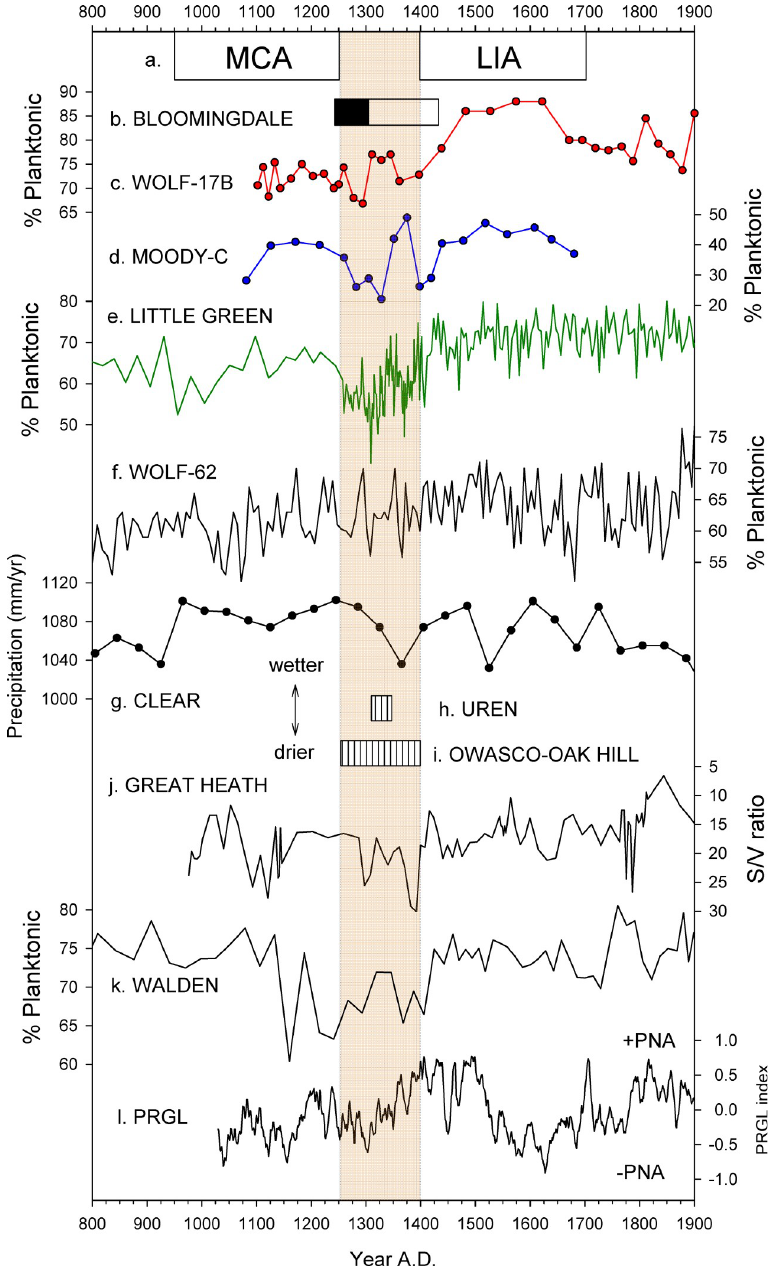
Fig 5. Paleoclimatic and cultural records of the last millennium. (a) MCA = Medieval Climate Anomaly, LIA = Little Ice Age. Tan column spans the MCA-LIA transition A.D. 1250–1400. (b) Age probability ranges for the resumption of peat deposition in Bloomingdale Bog after hiatus. Black box = this study, open box = [6]. (c-e) %P in cores from Wolf Lake, Moody Pond, and Little Green Pond, respectively (this paper). Chronologies are based on mean ages with multidecadal uncertainty ranges that could allow closer temporal alignment of peaks. (f) %P in core WOLF- 62 [5]. (g) Pollen-derived precipitation record from Clear Pond, NY [8]. (h, i) Cultural periods among Iroquoian cultures in southern Ontario [59]. (j) Hydrological reconstruction from Great Heath Bog, ME [10]. (k) %P in core from Walden Pond, MA [11]. (l) Composite PNA pattern reconstruction from NY and RI [12]. All proxy records are arranged with wetter conditions